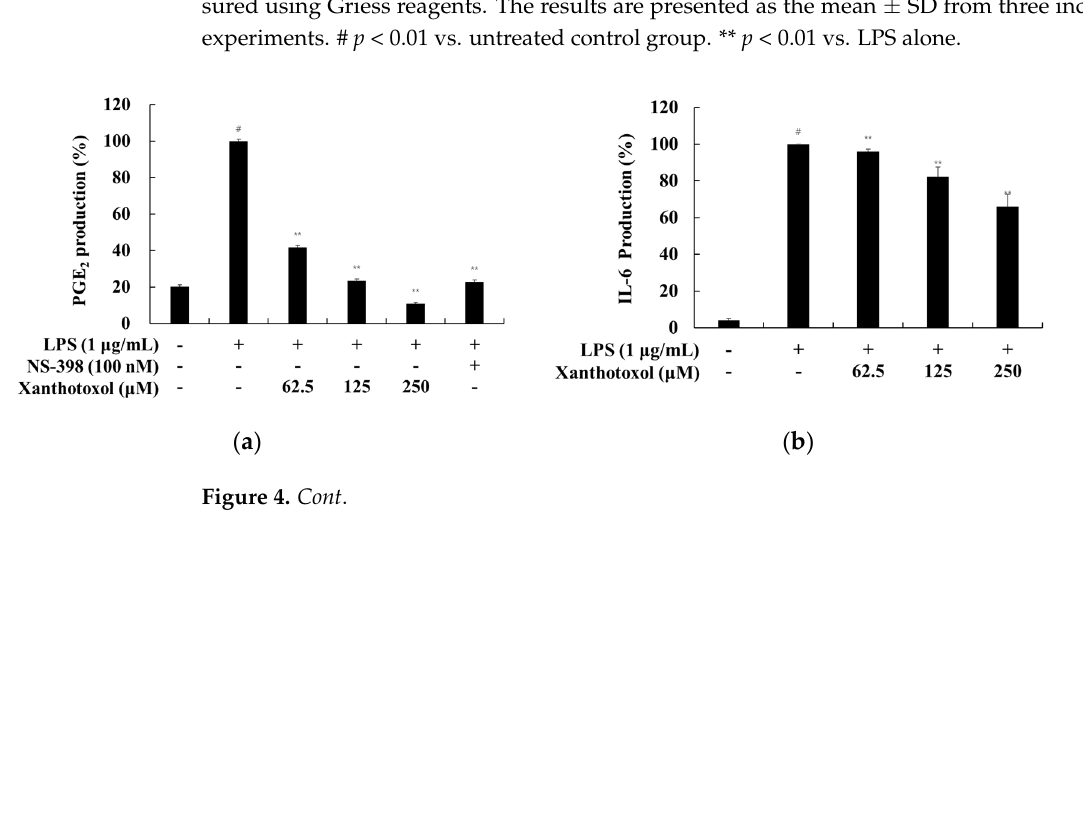
Figure 3. Effect of psoralen derivatives on nitric oxide production in LPS-induced RAW 264.7 cells. The cells were treated with psoralen derivatives (62.5, 125, and 250 μ M) and L-NIL (40 μ M) for 24 h with LPS (1 μ g/mL). L-NIL was used as a positive control. NO production of LPS-induced RAW 264.7 cells subjected to ( a ) 8-hydroxypsoralen (xanthotoxol), ( b ) 5-hydroxypsoralen (bergaptol), ( c ) 8-methoxypsoralen (xanthotoxin), and ( d ) 5-methoxypsoralen (bergapten) treatment were meas- ured using Griess reagents. The results are presented as the mean ± SD from three independent experiments. # p < 0.01 vs. untreated control group. * p < 0.05 and ** p < 0.01 vs. LPS alone.